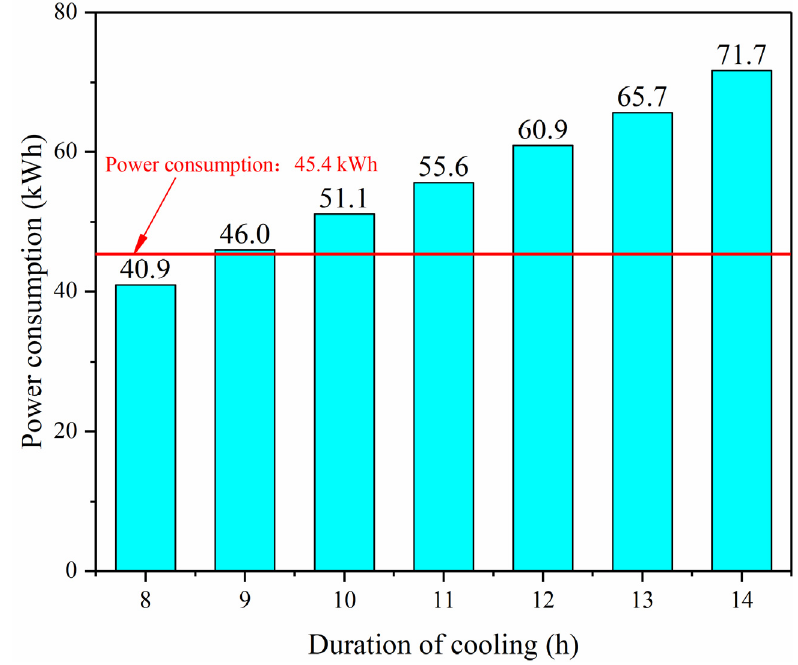
Figure 12. Power consumption at different cooling durations with STPV supply.